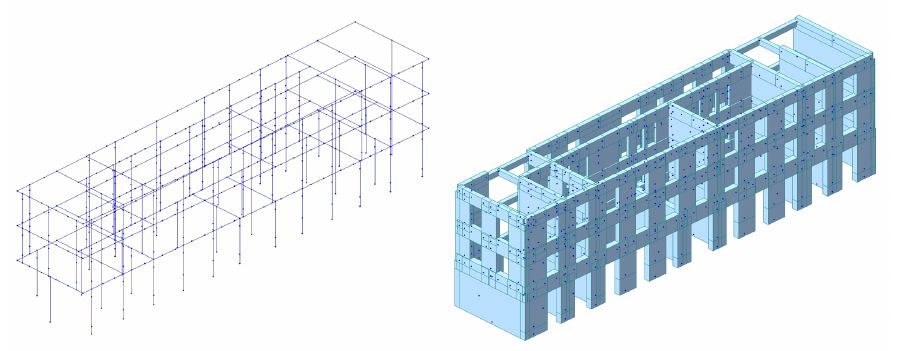
Figure 15. Wireframe ( left ) and solid ( right ) representation of the finite element model used for the non-linear analysis of the main building.